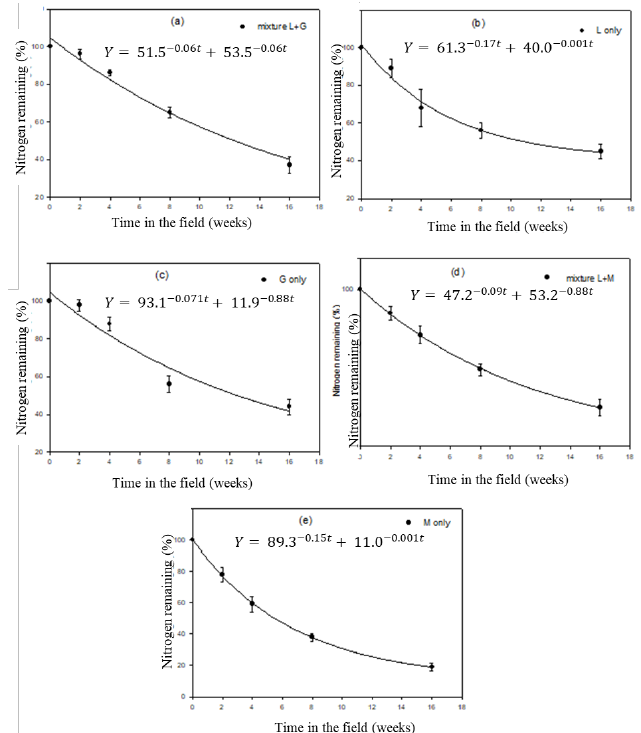
Figure 6. Modeled and measured nitrogen from decomposing leaves (( a ) = Leucaena + Guazuma , ( b ) = Leucaena , ( c ) = Guazuma , ( d ) = Leucaena + Moringa , ( e ) = Moringa ) for the dry period. Bars are SE.